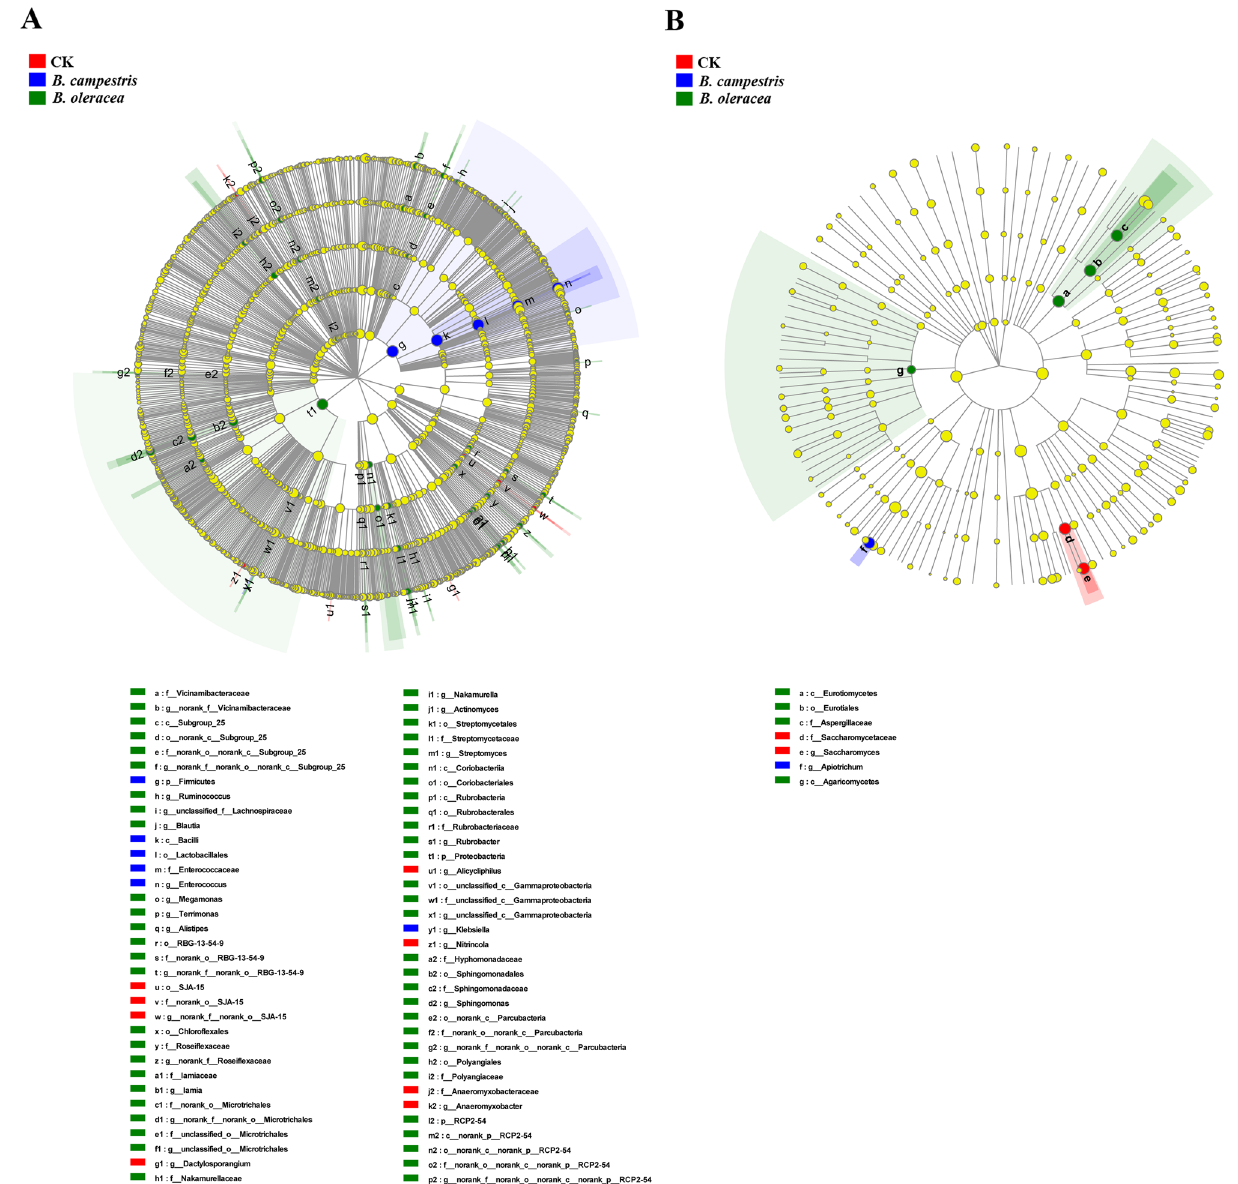
Figure 6. The results of the linear discriminant analysis effect size (LEfSe) cladogram from the phylum to genus. The threshold of Linear Discriminant Analysis (LDA) was set at 2. ( A ) The 16S database’s LEfSe cladogram; ( B ) The ITS database’s LEfSe cladogram. CK: the group fed on an artificial diet, Bc: the group fed on B. campestris; Bo: the group fed on B. oleracea. The figure was created by LEfSe software (version 1.0) (http:// hutte nhower. sph. harva rd. edu/ galaxy/ root? tool_ id= lefse_ 0.001 at the phylum level, respectively. All these results indicate significant differences in microbial community structures among different groups. Differential species analysis. Significant differences in bacterial and fungal taxa were also identified by linear discriminant analysis effect size (LEfSe) analyses. The LEfSe cladogram showed that 20 genera contributed to the different midgut bacterial communities in different groups. The genera Anaeromyxobacter , Alicycliphilus , Dactylosporangium, and Nitrincola were more abundant in the control group. Similarly, we found an enrich- ment of Sphingomonas , Nakamurella , Ruminococcus , Blautia , Gammaproteobacteria , Actinomyces , Streptomyces , Microtrichales , Alistipes , Megamonas , Iamia , Rubrobacter , Terrimonas , and Lachnospiraceae in the group fed on B. campestris , as well as Enterococcus and Klebsiella in the group fed on B. oleracea (Fig. 6A) . The LEfSe analyses in the midgut fungi community revealed a significant enrichment of Saccharomyces in the B. campestris group and Apiotrichum in the B. oleracea group (Fig. 6B) .